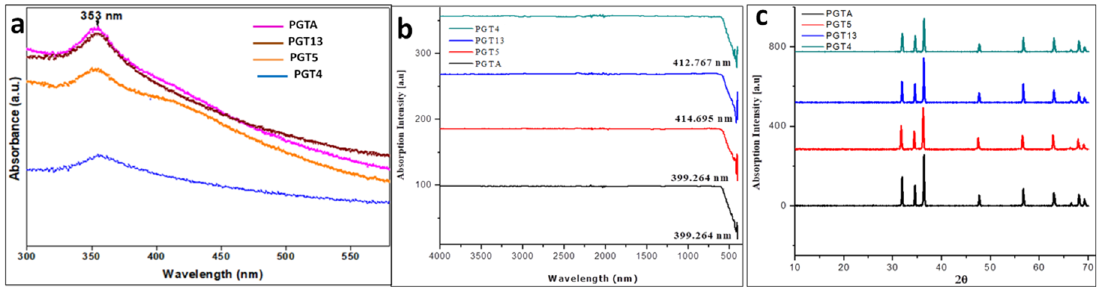
Figure 4. ( a ). UV−vis spectra of co-culture of Trichoderma sp. (PGTA), Trichoderma reesei (PGT5), Trichoderma reesei (PGT13) and Trichoderma harzianum (PGT4); ( b ) FT-IR Spectrogram of synthesized ZnO NPs Trichoderma harzianum (PGT4), Trichoderma reesei (PGT13), Trichoderma reesei (PGT5) and co-culture of Trichoderma sp. (PGTA); ( c ) PXRD patterns of ZnO NPs of Trichoderma spp.; co-culture of Trichoderma spp. (PGTA), Trichoderma reesei (PGT5), Trichoderma reesei (PGT13) and Trichoderma harzianum (PGT4).